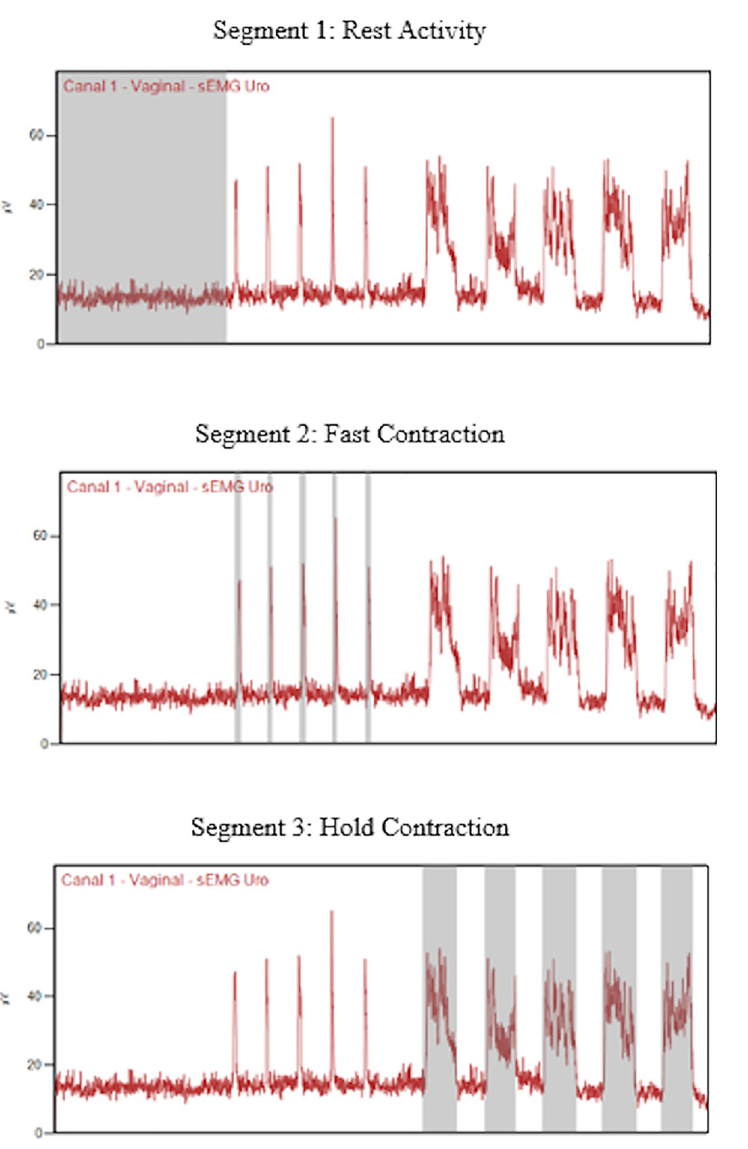
Fig 2. Hanning window procedure for rest activity and fast and hold